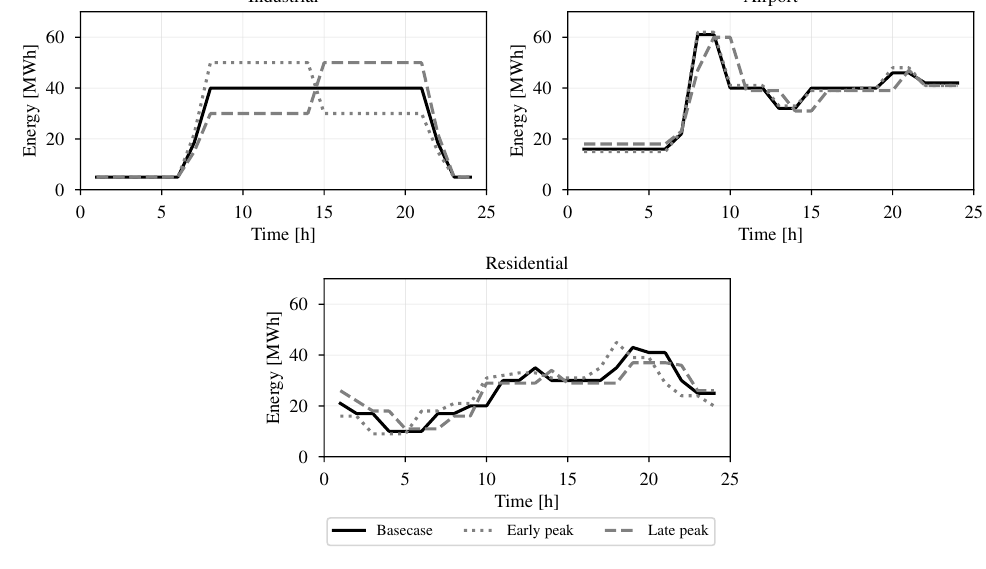
Figure 5. Demand